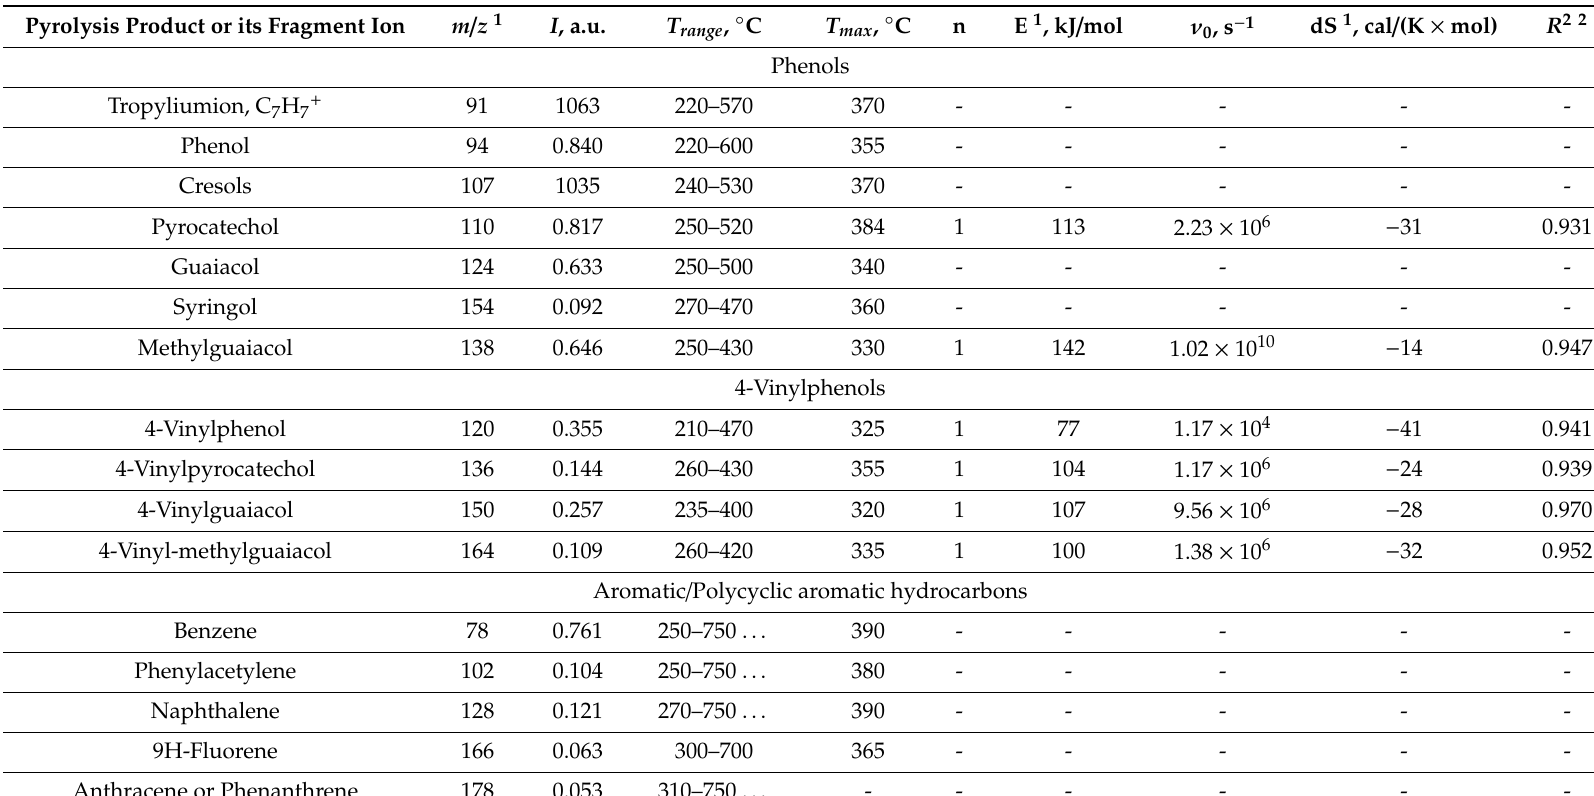
Table 2. Kinetic parameters (temperature of the maximum desorption rate T max , reaction order n , activation energy E (cid:44) , pre-exponential factor ν 0 , and activation entropy dS (cid:44) ), temperature range ( T range ) of formation and peak intensities ( I ) of thermo-programmed reactions products during hydrolytic lignin